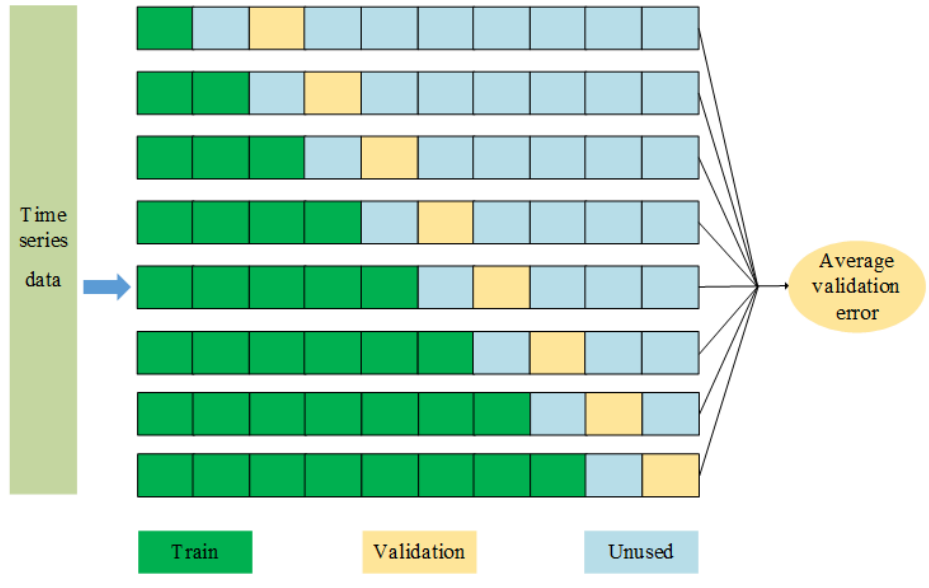
Figure 3. Illustration of rolling